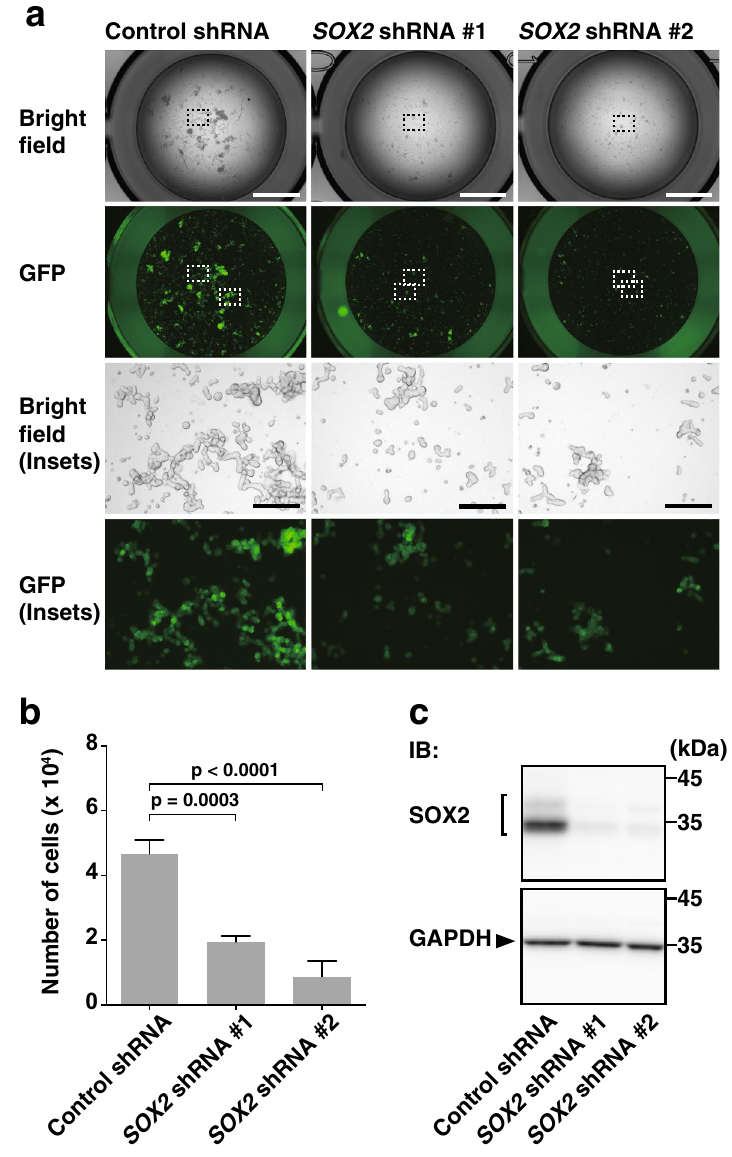
Figure 4. SOX2-dependent enhancement of T47D cell proliferation by nectin-4 and p95-ErbB2 in a suspension culture. ( a , b ) Requirement of SOX2 for the enhancement of T47D cell proliferation by nectin-4 and p95-ErbB2 in a suspension culture. The T47D cells stably expressing GFP-tagged p95-ErbB2 (p95-ErbB2-GFP) with FLAG- tagged nectin-4 (FLAG-Nectin-4) that also stably express control shRNA or SOX2 shRNAs were detached using Accutase. The cells were collected, their numbers were counted, and the same numbers of the cells were seeded in the serum-free medium with supplements on ultra-low attachment 6 well dish. After the incubation for 28 days, the cells were collected and transferred to ultra-low attachment 96 well dish for image acquisition. Then, the cells were re-collected and subjected to quantitative analysis by cell counting as shown in ( b ). The displayed images were acquired using a BZ-X710 microscope and its software BZ-X Analyzer (https:// www. keyen ce. co. jp/ produ cts/ micro scope/ fluor escen ce- micro scope/ bz- x700/ models/ bz- x710/) with BZ-H3A Advanced Application software (https:// www. keyen ce. co. jp/ produ cts/ micro scope/ fluor escen ce- micro scope/ bz- x700/ models/ bz- h3a/) for image connection. ( c ) Decrease in the amount of the SOX2 protein by SOX2 knockdown. The T47D cells stably expressing p95-ErbB2-GFP with FLAG-Nectin-4 that also stably express control shRNA or SOX2 shRNAs were cultured for 72 h in an adherent culture. The cells were subjected to Western blotting using the indicated Abs. Arrowhead and square bracket indicate each of the proteins. The displayed blots were cropped, and the full- length blots are shown in Supplementary Figure S5. All the cell lines used in the experiments were the bulk of collected cells and not singly picked-up clones. Bars indicate the means ± S.D. of three independent experiments and the actual P values for each test are shown. Scale bars 2000 μm or 200 μm (insets). IB, immunoblotting. Representative results (images) from three independent experiments were